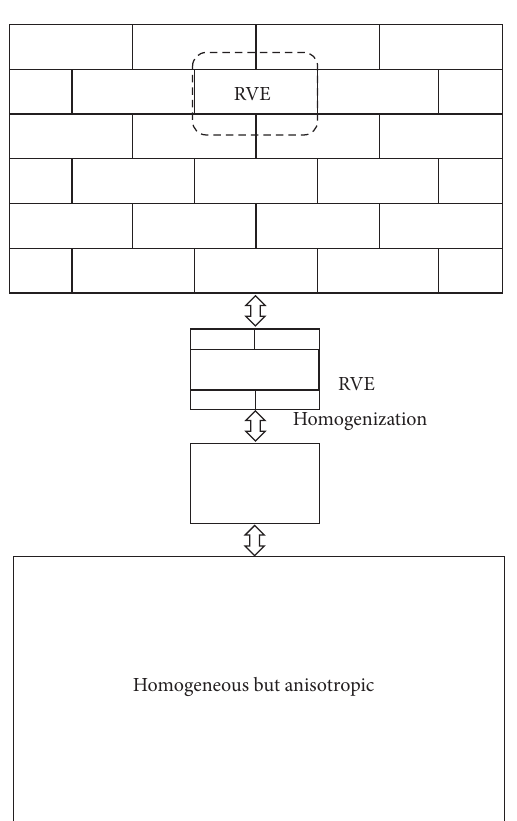
Figure 1: Homogenization of masonry